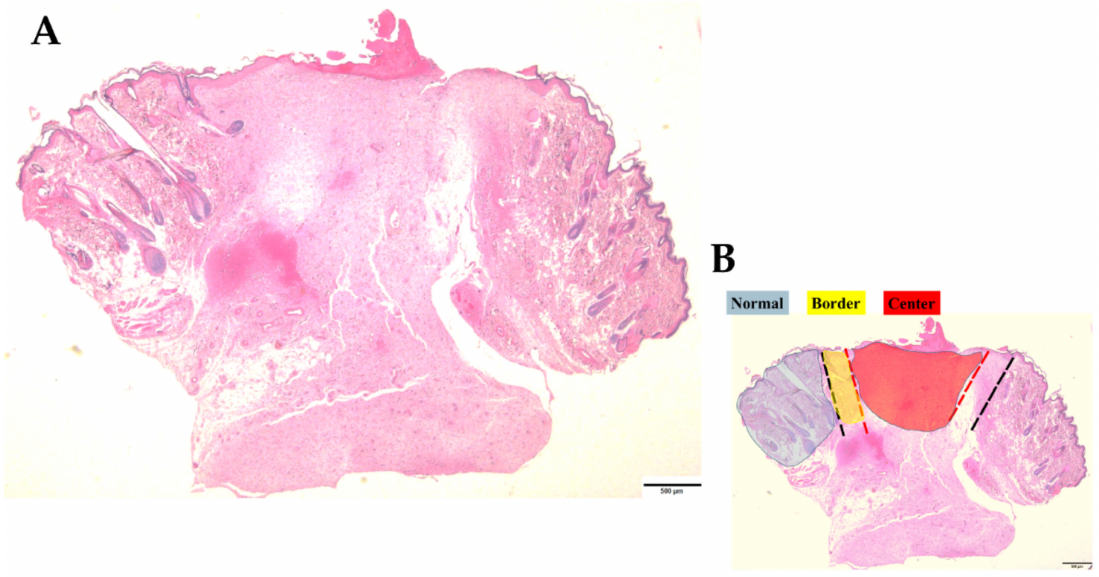
Figure 1. Schematic image of a skin sample stained with Hematoxylin and Eosin (HE). ( A ) shows a whole vision of a skin sample by a microscope in 2 × lens. ( B ) schematizes the three analyzed regions in the experiment (unwounded or normal skin, border and center of the wounds), delimitating them by colors: the normal region in blue, the border in yellow and the center in red. Bars 500 µ